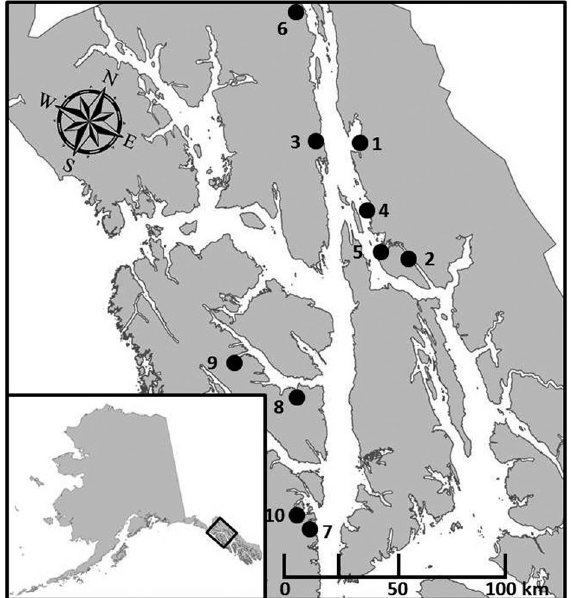
Fig. 1. Northern southeast Alaska depicting Sawmill Creek (1) and DIPAC hatchery (2); remote release locations of Boat Harbor (3) and Amalga Harbor (4); and source locations for Douglas Island Pink and Chum (DIPAC) broodstock as defined in Stopha (2014) as Sawmill Creek (1), Fish Creek (5), and Klehini River (6), as well as Salmon Creek and Kowee Creek (not shown; each within 3 km of DIPAC). Hidden Falls Hatchery (7) stocks were developed from Kadashan River (8), Seal Bay Cove (9), and Clear River